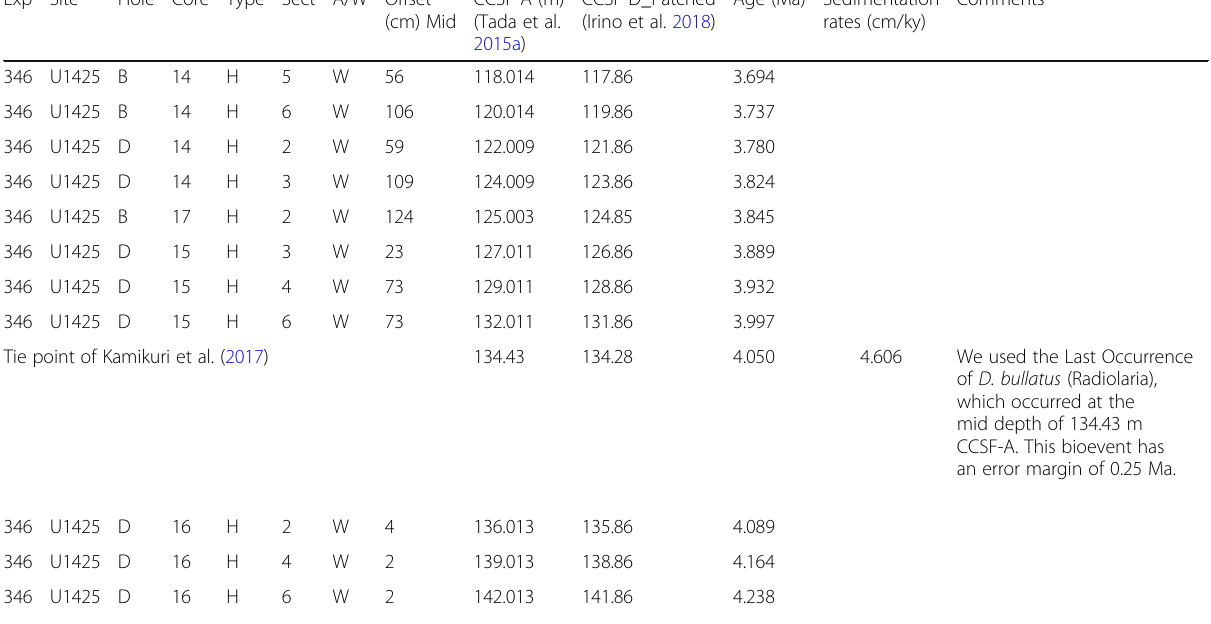
Table 1 Samples used, biostratigraphic tie points, and related sedimentation rates at IODP Site U1425 (cm/ky) (Continued) Exp